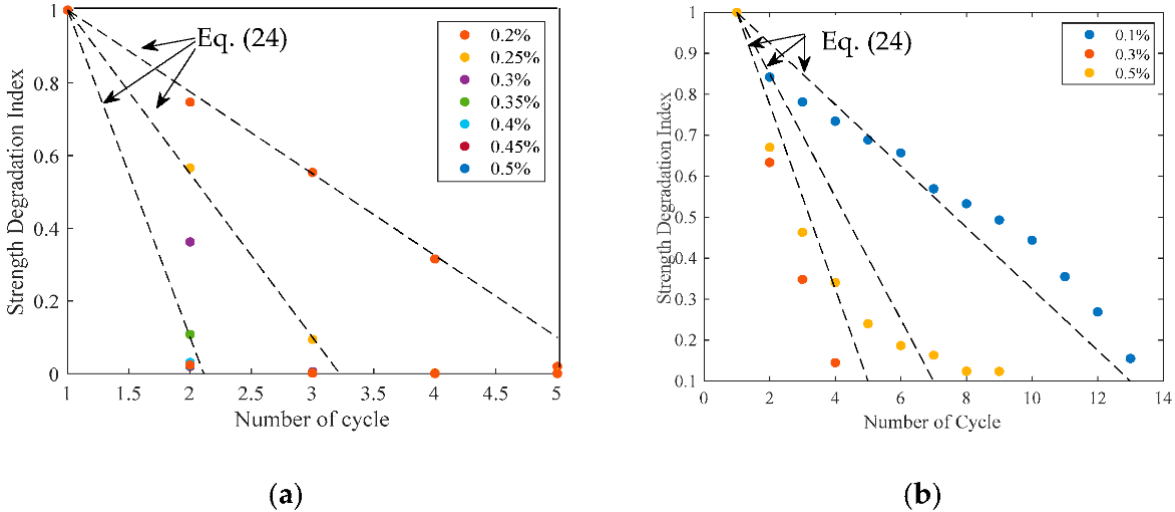
Figure 11. Linear Strength Degradation Model for several maximum levels of strain: ( a ) loose sand; ( b ) medium-dense sand.